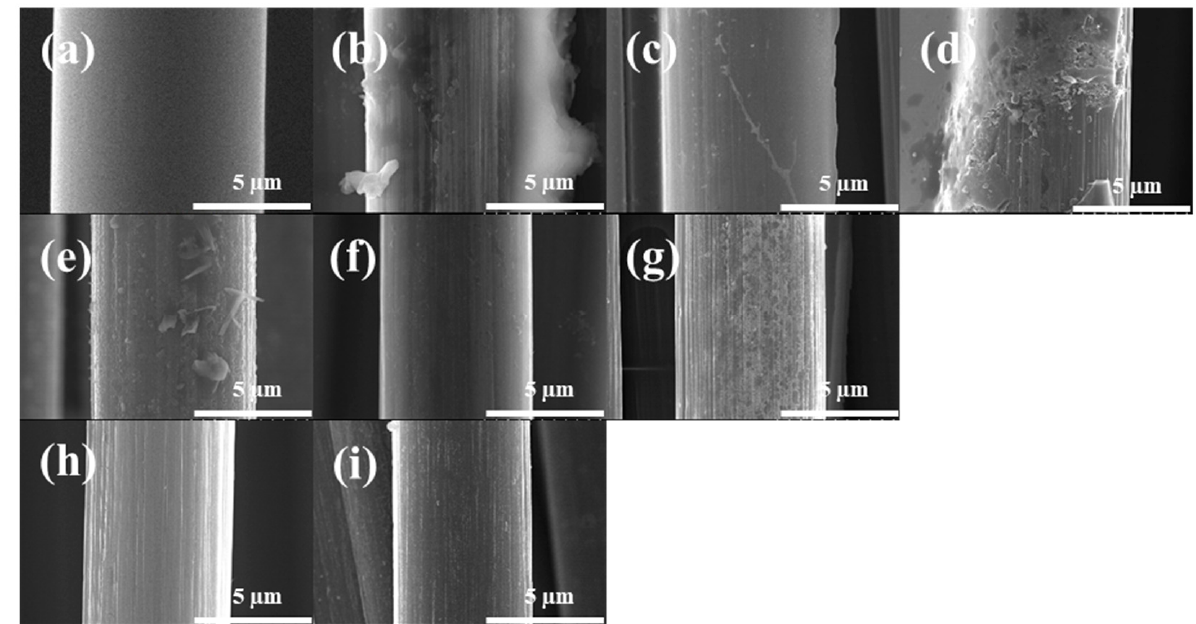
Figure 6. Scanning electron microscopy images of the as-received and recycled carbon fibers under varying pyrolysis conditions; ( a ) Ar-CF, ( b ) 50, ( c ) 55, ( d ) 60, ( e ) 50-50-10, ( f ) 50-55-10, ( g ) 50-60-10, ( h ) 55-60-10, and ( i ) 60-60-10.